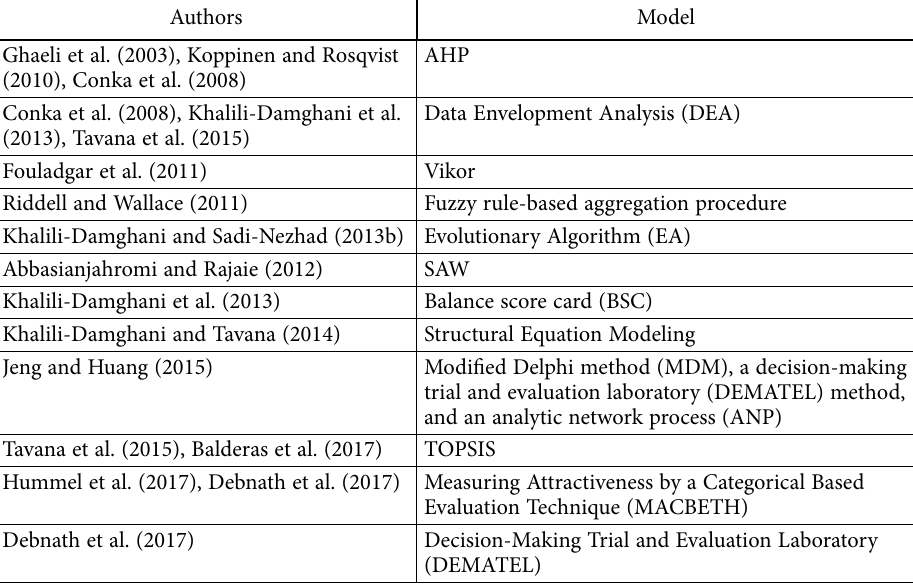
Table 13. Ranking and scoring approaches in PPS